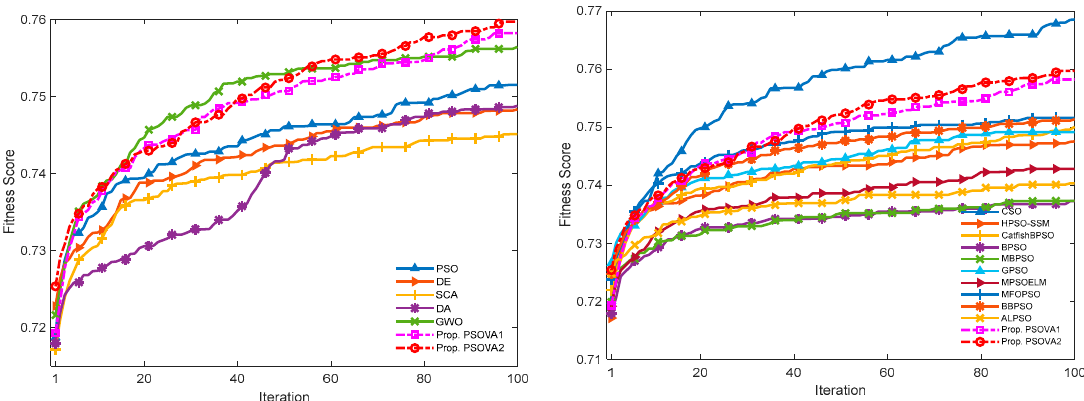
Figure 4. Mean convergence curves over 30 runs for the classical search methods (left) and advanced PSO variants (right) for the Multiple Myeloma data set (where x and y axes denote the iteration number and the fitness score, respectively.).